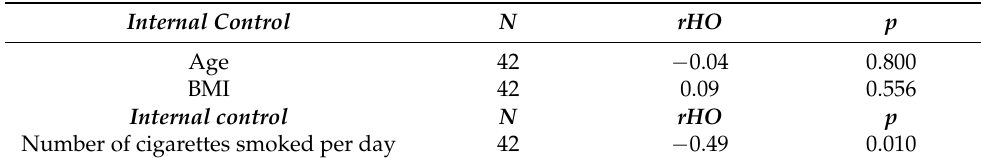
Table 4. Internal control vs. age, BMI, and nicotine addiction. Internal Control